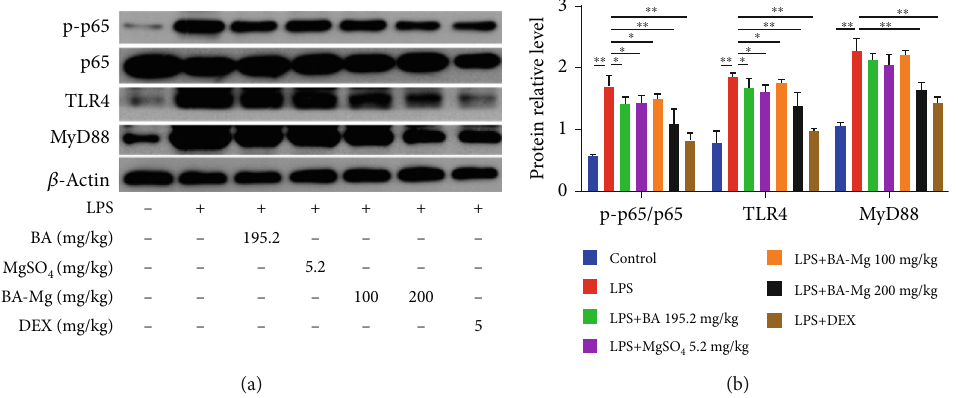
Figure 5: E ff ect of BA-Mg on TLR4/NF- κ B signaling pathway in lung tissue of mice injured by LPS: (a) western blot analysis; (b) statistical results of western blot analysis. Data were represented as mean ± SD ( n = 5 ). ∗ P < 0 : 05 , ∗∗ P < 0 : 01 versus LPS Mg, the in fl ammatory cytokine expressions of TNF- α , IL-1 β ,